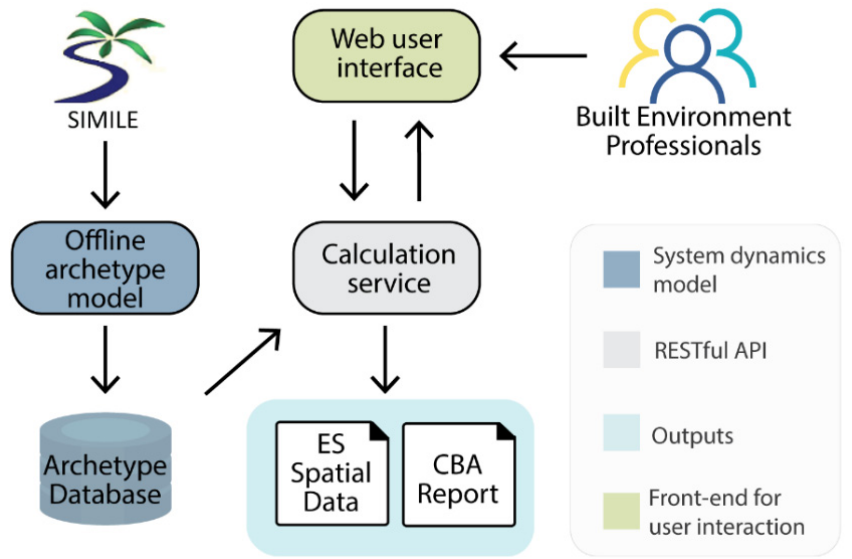
Figure 5. Relationship between the main components of NBenefit$ and their outputs; CBA = costs- benefits analysis; ES = ecosystem services; API = application programming interface.